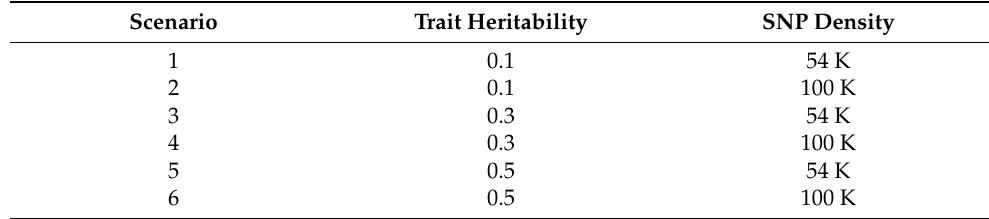
Table 1. Different genetic architecture of